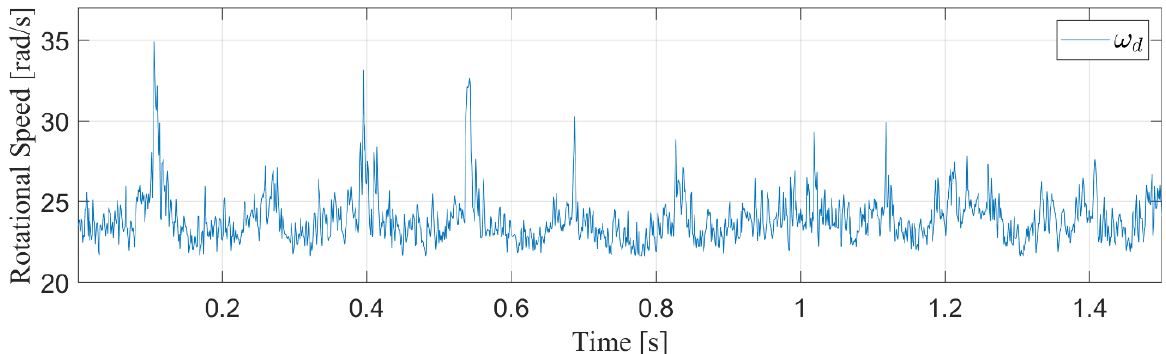
Figure 5. Desired speed trajectory for controller comparison.